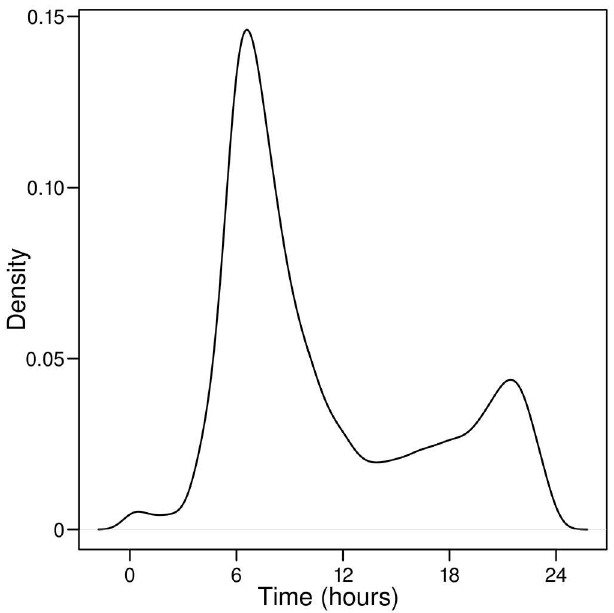
Fig 3. Estimated weighted probability density function for starting times of single ATUS grooming events. N = 54,094.